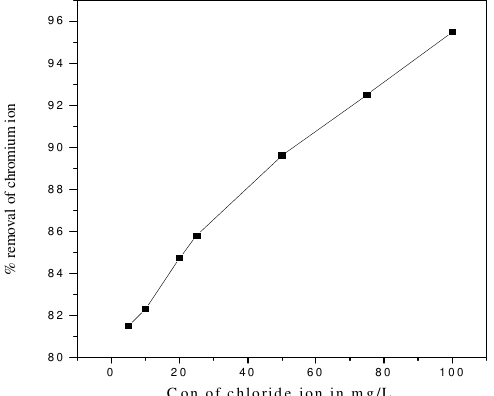
Figure 7. Effect of ionic strength on the adsorption of chromium ion onto PDC[Cr]=20 mg/L, pH=7; Dose=50 mg/50